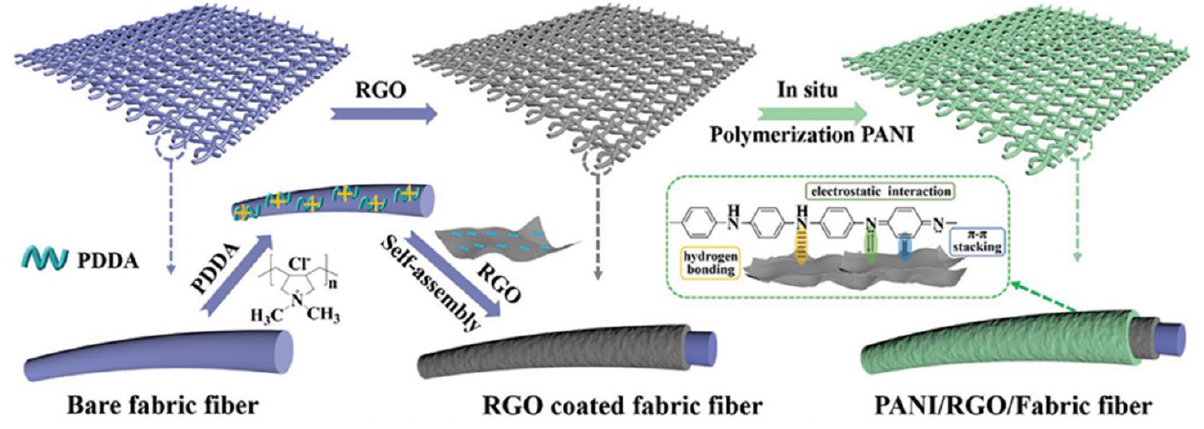
Figure 10. Schematic representation of a PANI@rGO/PMFT. Reprinted with permission from ref. [155]. 2021 John Wiley and Sons.